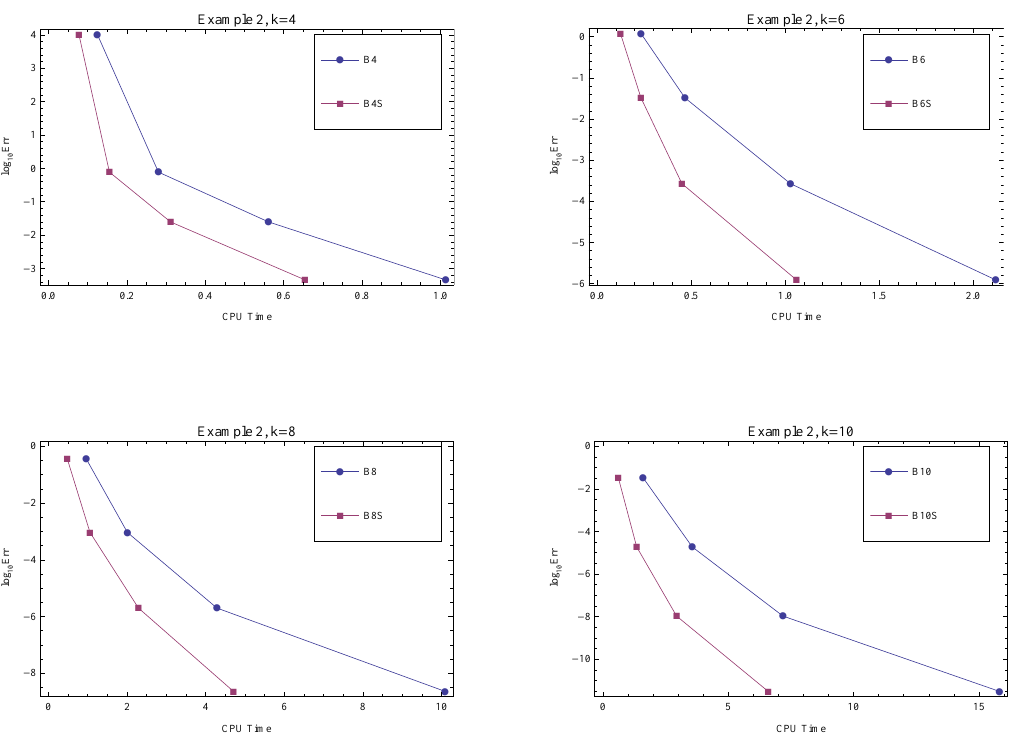
Figure 4. Efficiency curves for Example 2 comparing performances of usual